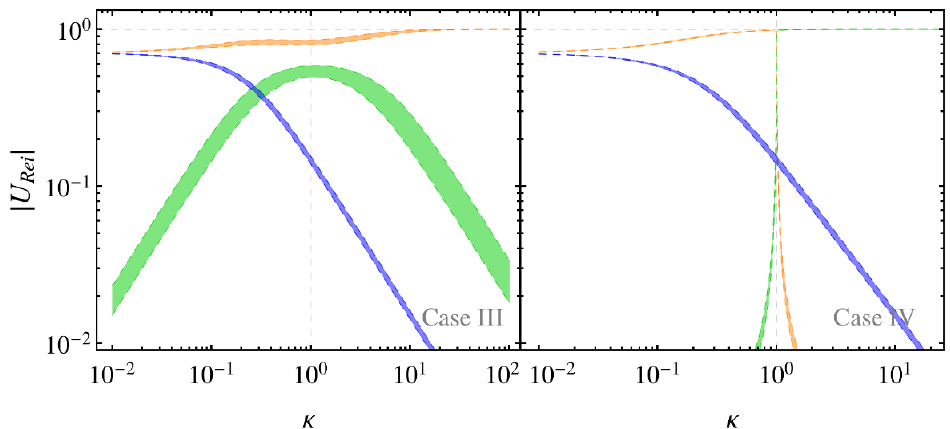
Figure 7 . Modulus of U R 1 i for our IO solutions (cases III and IV) for i = 1 ; 2 ; 3 (orange, green, blue) as a function of (cid:20) . We use the 3- (cid:27) ranges in ref. [56] for the observables not (cid:12)xed by